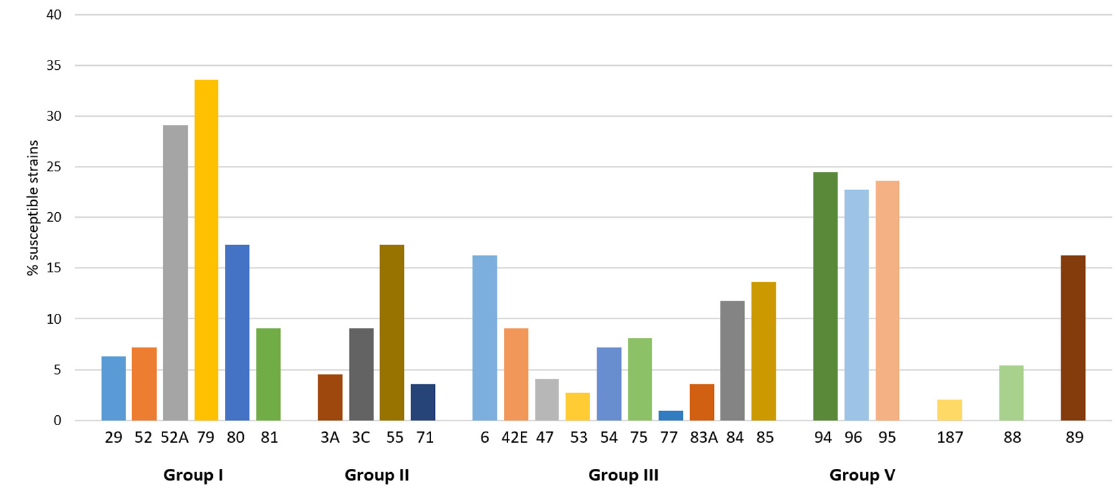
Figure 2. Sensitivity of 110 oral S. aureus strains to specific lytic phages from international set.